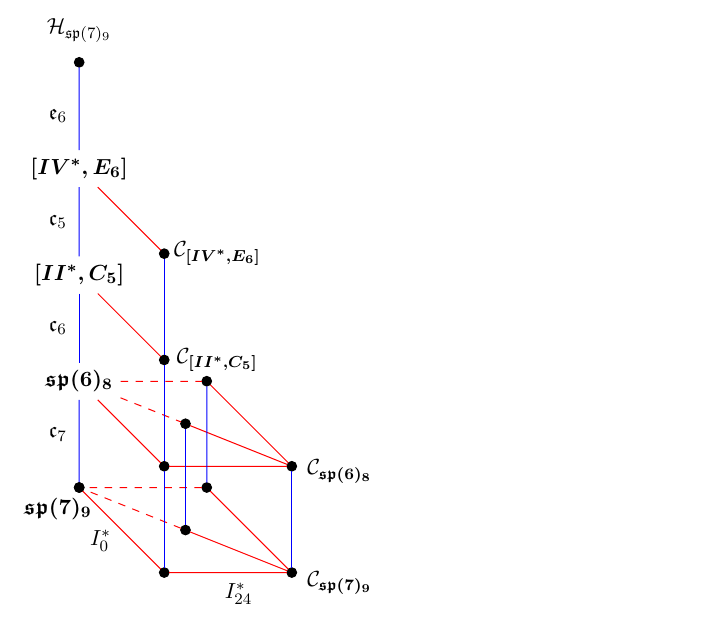
Figure 27. The Hasse diagram for the full moduli space of the sp (7) 9